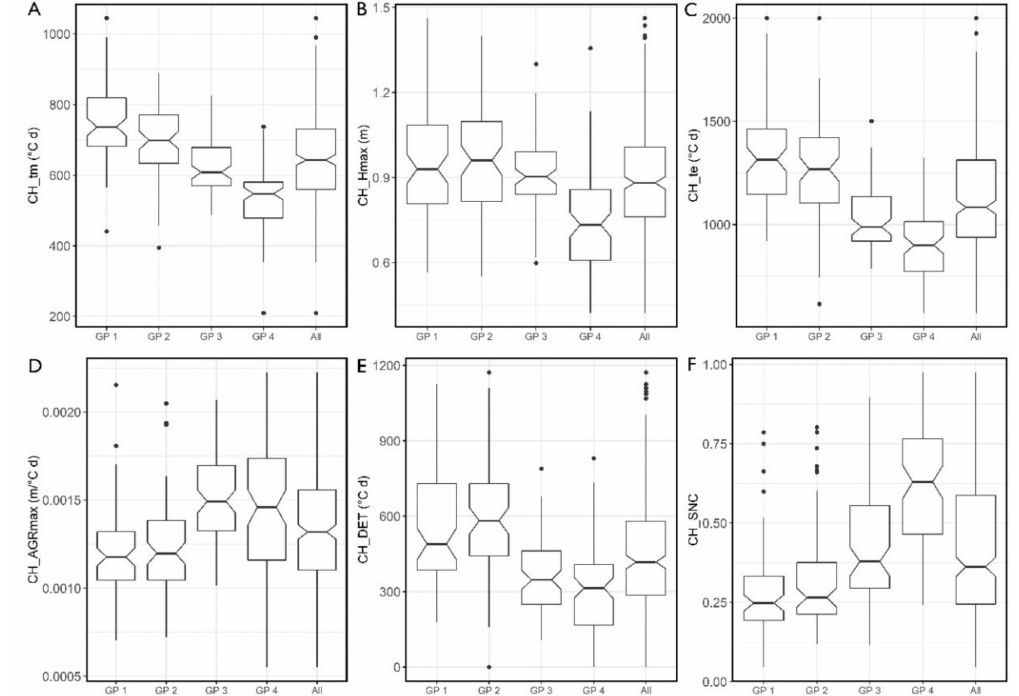
Figure 5. Notched boxplots of the phenotypic parameters ( a – f ) derived from the curve fitting of canopy height data. The data is presented per group (GP 1–4) and all groups together (All). For abbreviations see Table